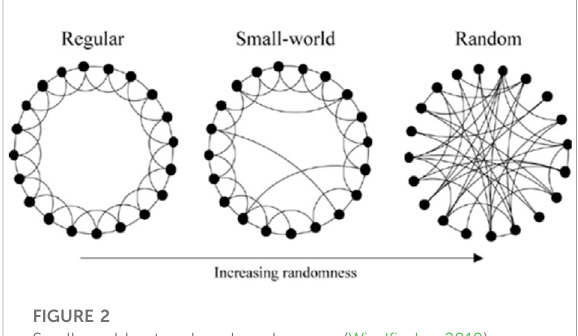
FIGURE 2 Small-world network and randomness (Wind fi nder,